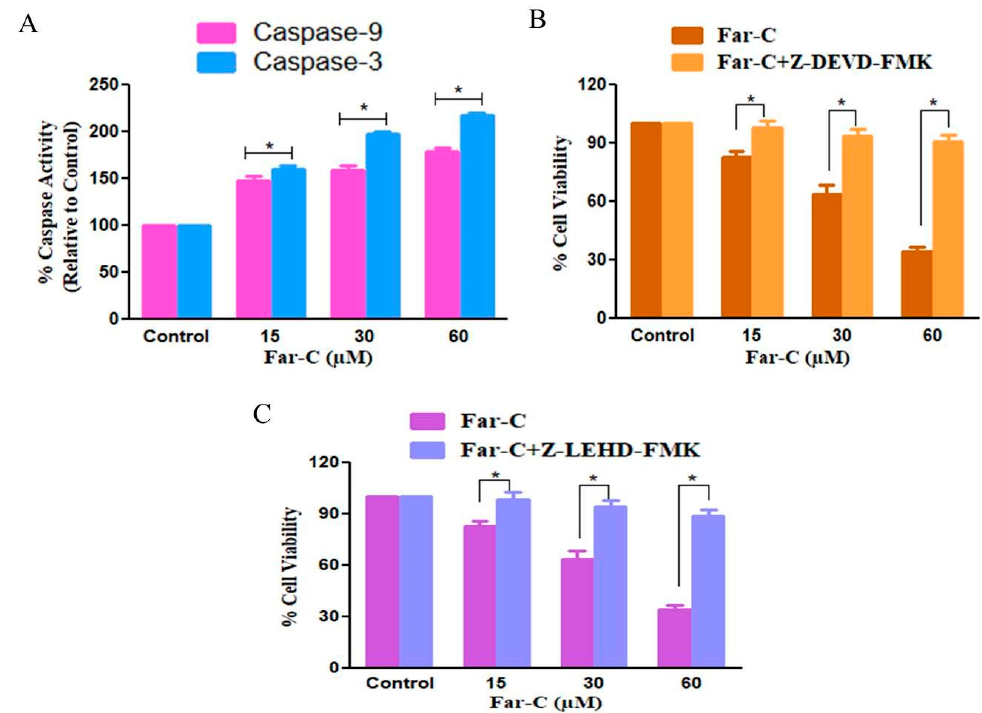
Figure 6. ( A ) Activation of different caspases post-exposure with Far-C, ( B ) the effect of caspase-3 and ( C ) caspase-9 inhibitor in ameliorating Far-c mediated apoptosis. * p < 0.05. and ( C ) caspase-9 inhibitor in ameliorating Far-c mediated apoptosis. * p <